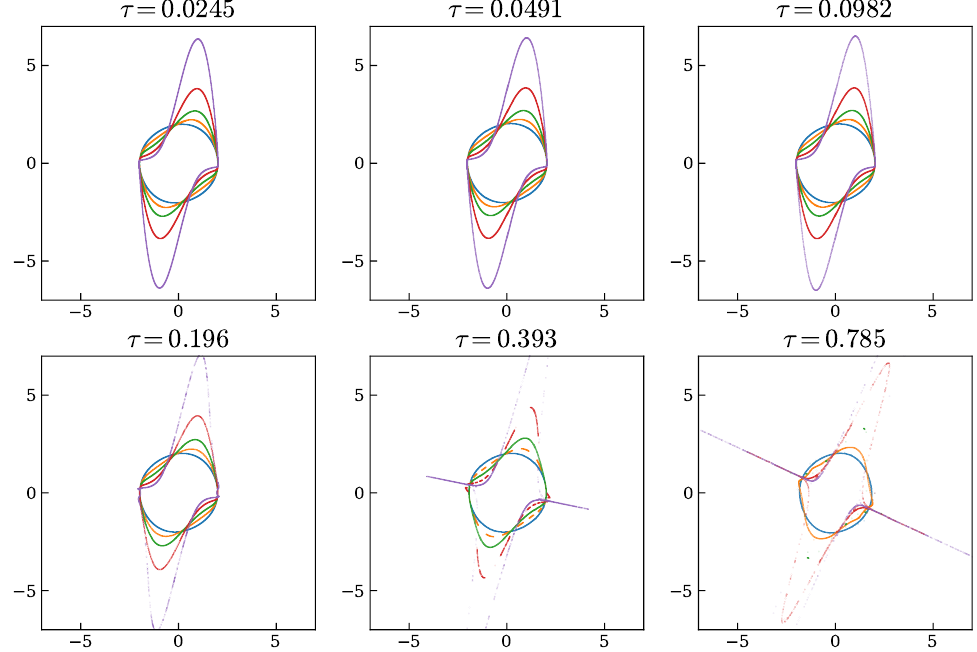
Figure 3. Limit cycle of the van der Pol oscillator computed with the second-order contact integrator for values of (cid:101) = 0.1 (blue), 0.5 (orange), 1 (green), 2 (red), 4 (purple) and with different time